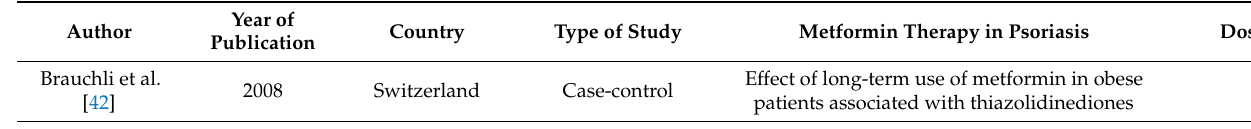
Table 3. Studies on metformin administration in psoriasis